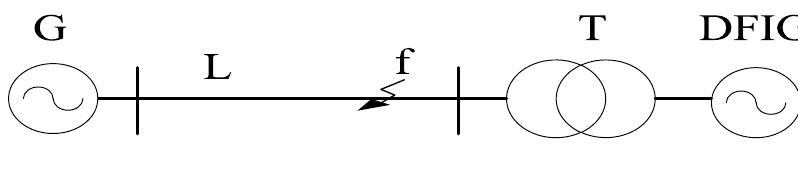
Figure 5. Test system of the